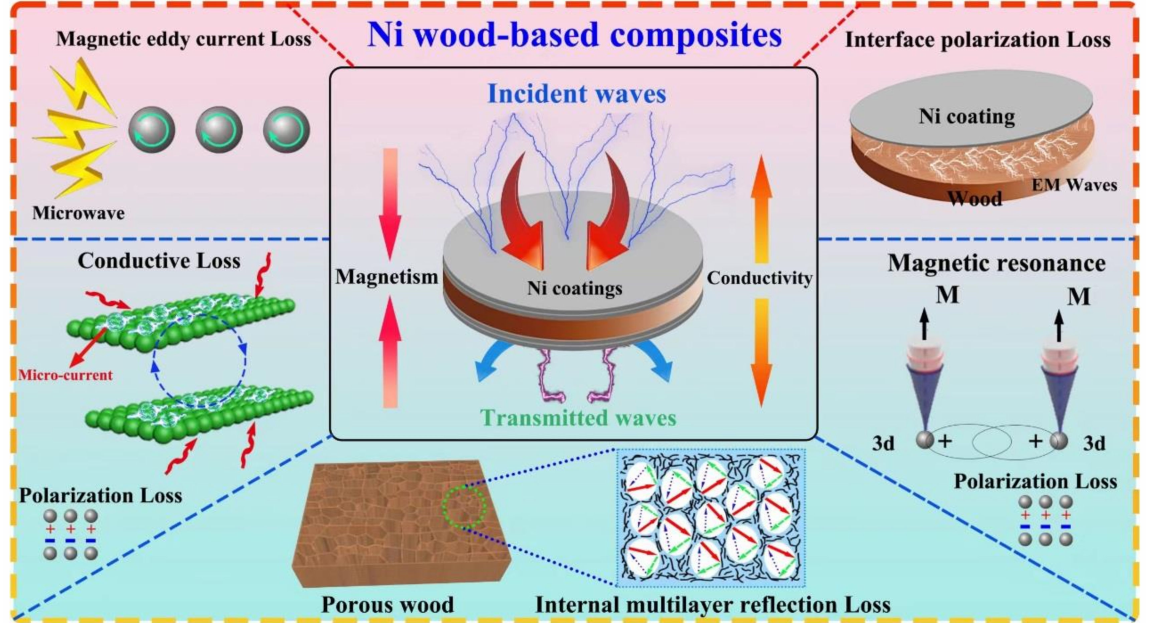
Figure 10. Diagram of electromagnetic shielding mechanism of wood metal